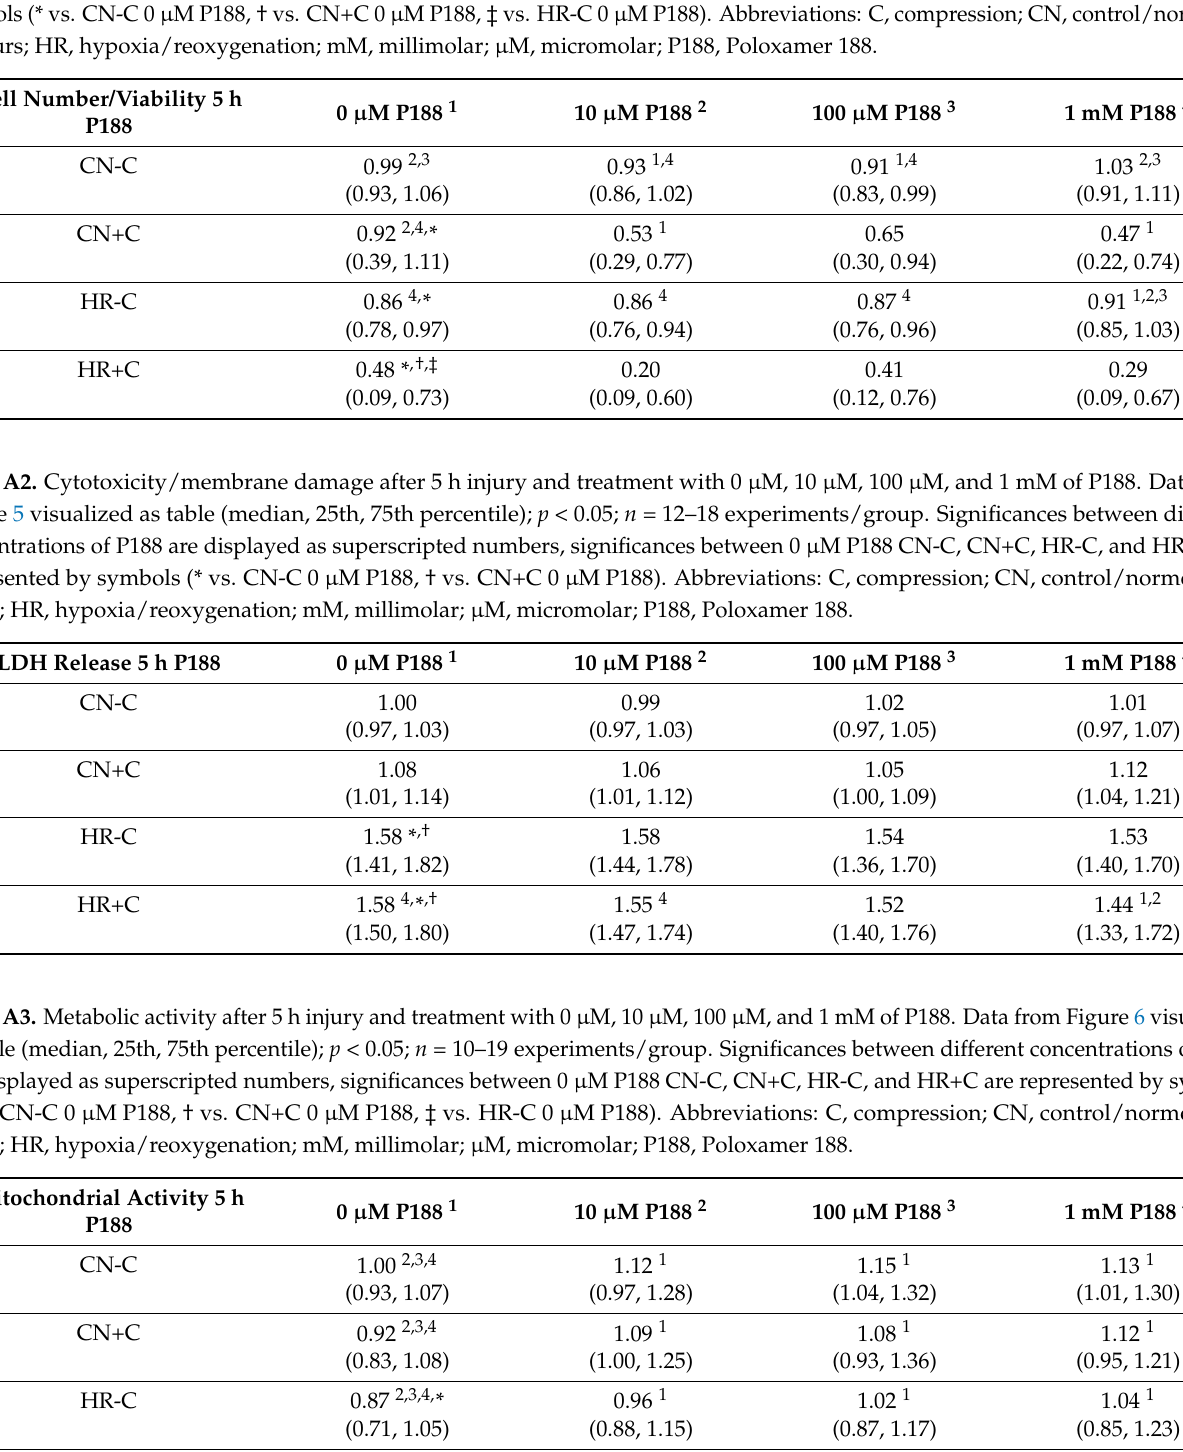
Table A1. Cell number/viability after 5 h injury and treatment with 0 µ M, 10 µ M, 100 µ M, and 1 mM of P188. Data from Figure 4 visualized as table (median, 25th, 75th percentile); p < 0.05; n = 12–19 experiments/group. Significances between different concentrations of P188 are displayed as superscripted numbers, significances between 0 µ M P188 CN-C, CN+C, HR-C, and HR+C are represented by symbols (* vs. CN-C 0 µ M P188, † vs. CN+C 0 µ M P188, ‡ vs. HR-C 0 µ M P188). Abbreviations: C, compression; CN, control/normoxia;